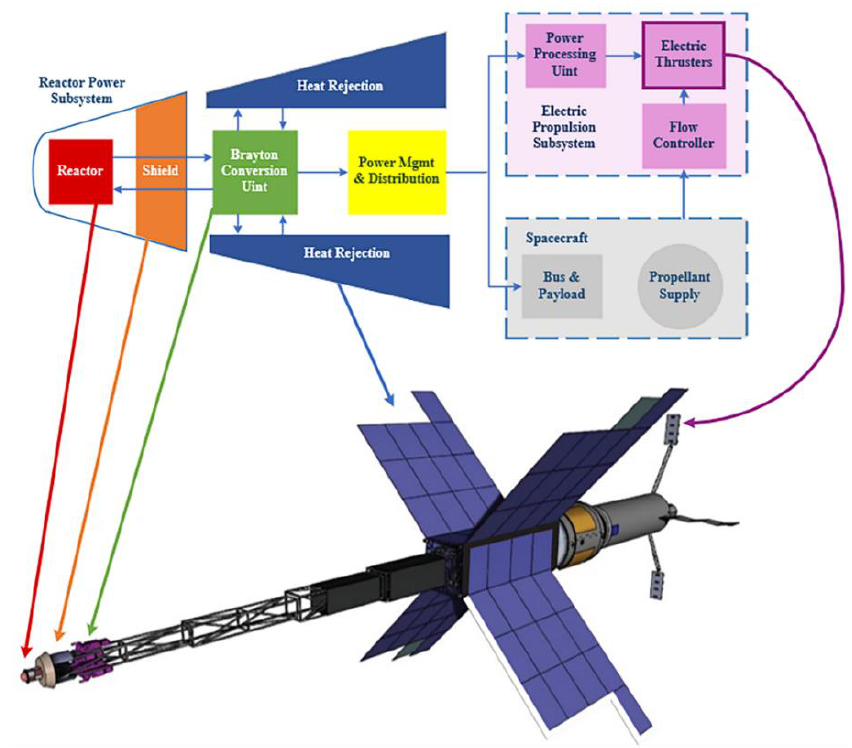
Figure 2. NEP subsystems and conceptual design.